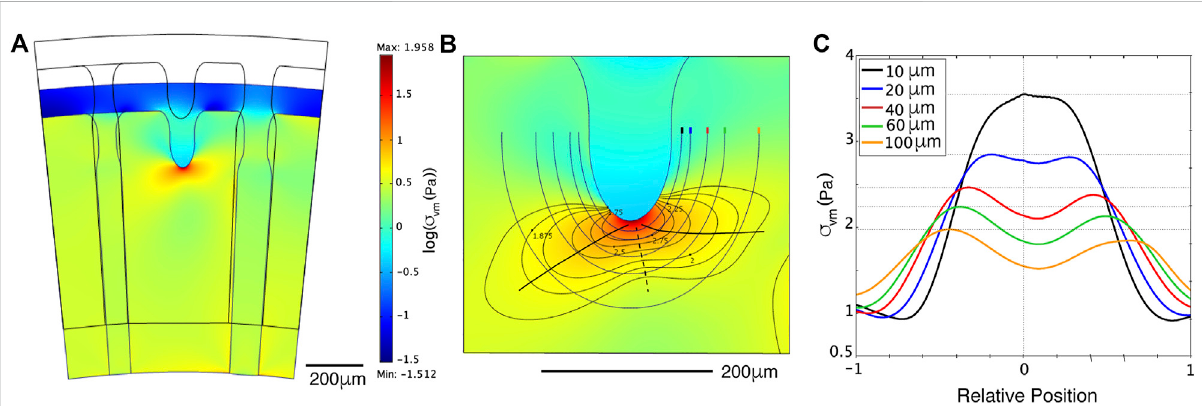
FIGURE 4 Stressdistributionpredictedbynumericalsimulations (A) :Finiteelementsimulationwithstifferyoungcanal(left)andsofteroldcanal(right).The contraction is reproduced by reducing the radial distance with a constant angle, thus reducing the orthoradial one. The log of the mechanical stress (coloredscale)issmaller(blue-green)inthesoftrightcanal,andreducedaroundthesproutingcanal(lightblue),butconcentratedatitstip(redspot). (B) :A zoom ofthestressaround thetip.Levellines, circling awaytheredspot reveal twolobes,one forward leftto theyoung canal,onerightto the old canal. Lines drawn at fi xed distances are drawn with each its color code, to measure the stress along them. The two stress maximums and minimum along these successive lines are indicated by black full and dotted lines, respectively. (C) : The stress measured along these lines, centered on the axial position of the tip and rescaled from beginning to end, with their colors, and the distance to the fi nger indicated. Horizontal dotted lines show that the left maximum toward the young canal is always higher. This will turn the propagation of the new canal sprout toward the younger, stiffer